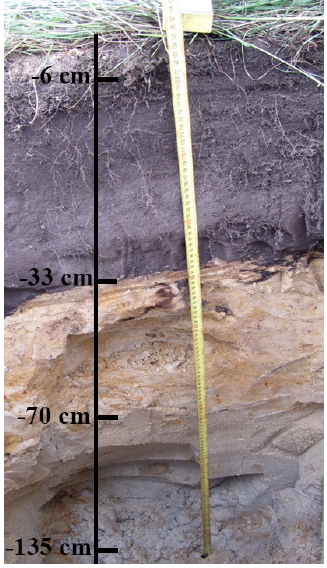
Figure 2. Two-layered typical soil profile of the field close to the location of the